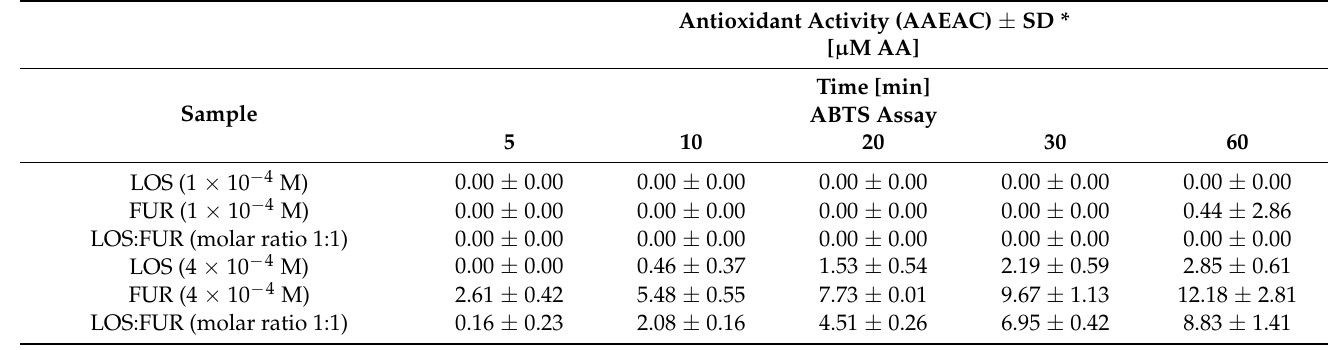
Table 6. The Total Antioxidant Capacity (AAEAC) (ABTS